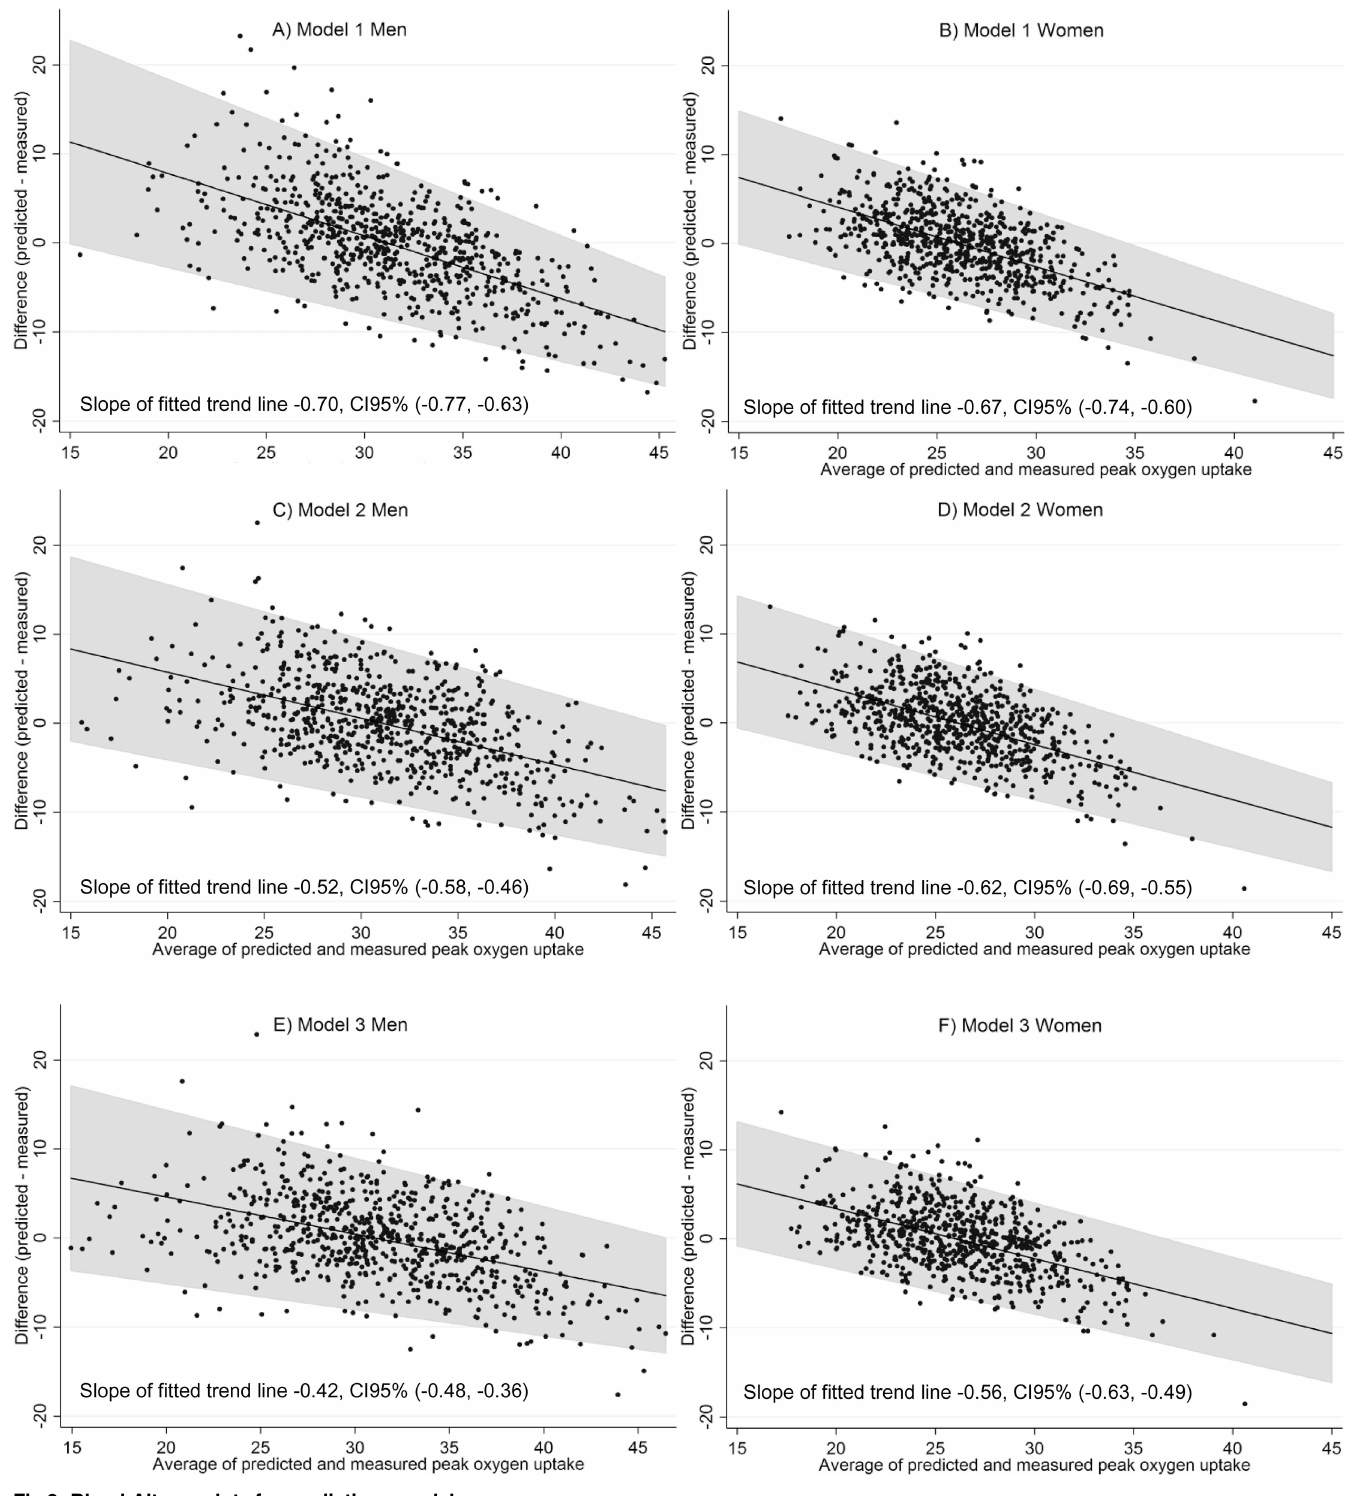
Fig 2. Bland-Altman plots for predictions models.